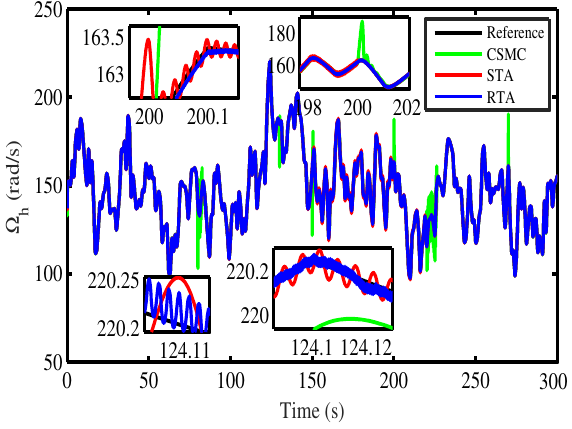
Figure 13. PMSG side-shaft speed.